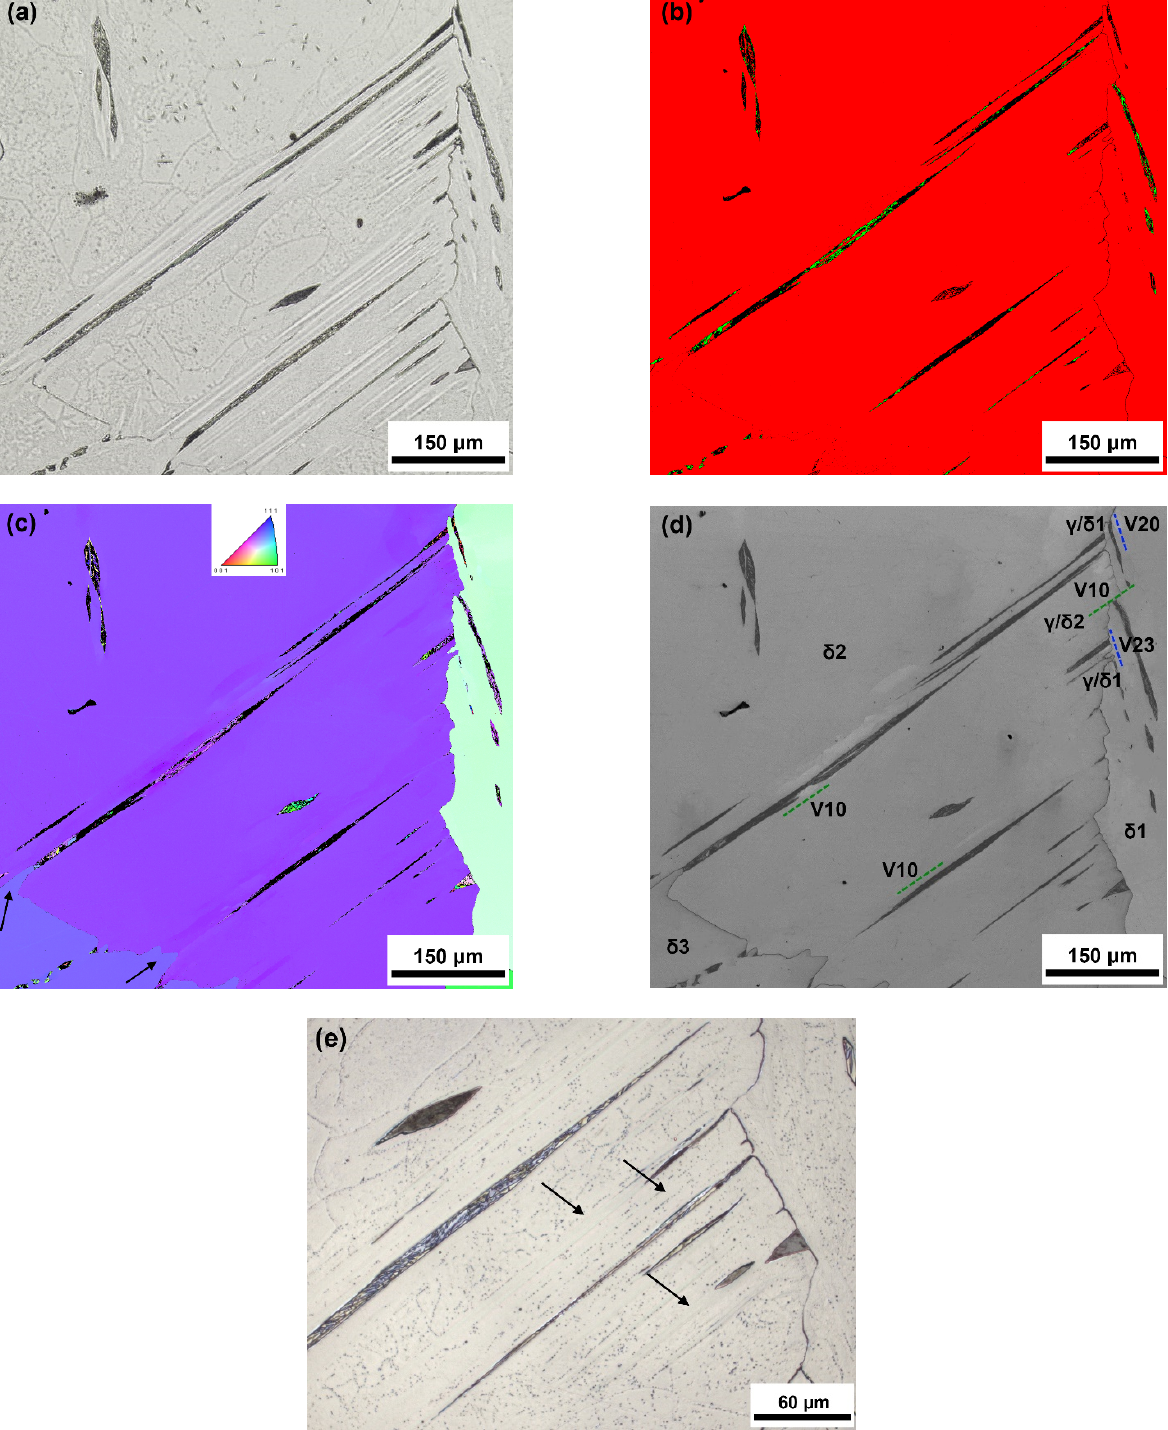
Figure 12. ( a ) Growth of parallel WA laths in the δ 2 ferritic grain nucleated on the opposite segments of the grain boundary ( δ 1 / δ 2 and δ 2 / δ 3 ), LM; ( b ) phase map: red = ferrite, green = retained austenite; ( c ) IPF orientation map for the normal direction (ND); ( d ) IQ map with marked traces of the γ/δ 1 and γ/δ 2 interfaces along the δ-ferrite grain boundary and directions of the WA growth in ferritic grains (V10: green lines, V20 and V23: blue lines); ( e ) networks of sulfides along the original δ-fer- rite/WA lath interfaces and precipitation-free epitaxial ferrite (arrows).